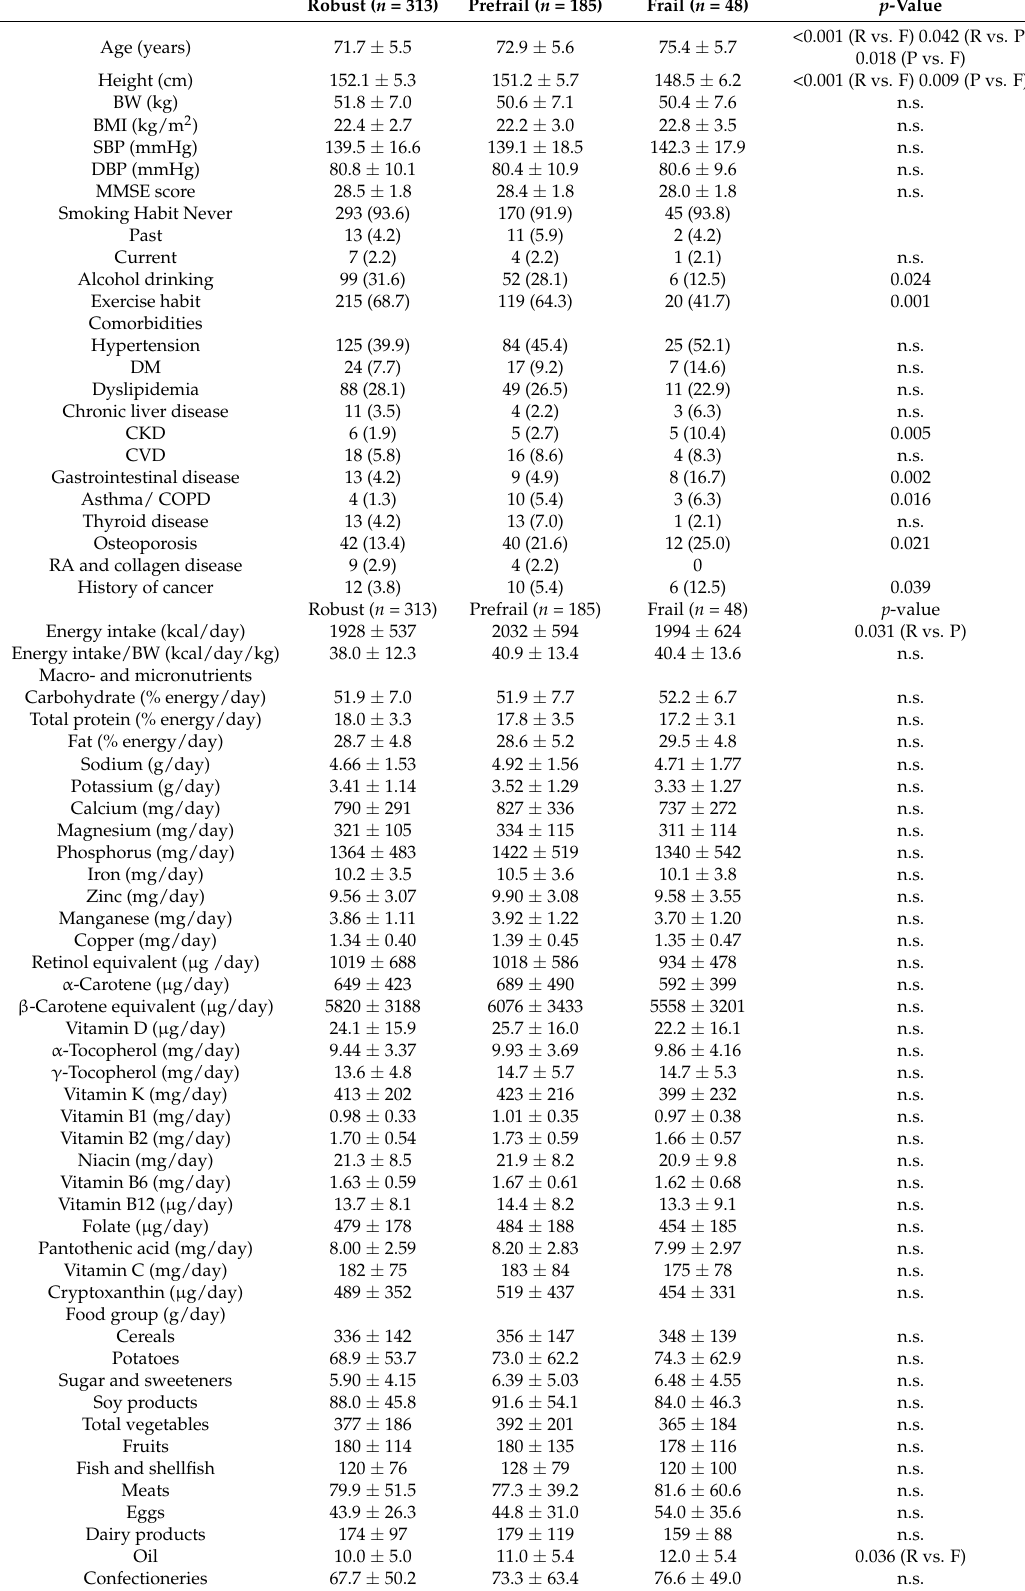
Table 3. Basic characteristics and dietary habits among frail, prefrail, and robust women, as diagnosed by the KCL